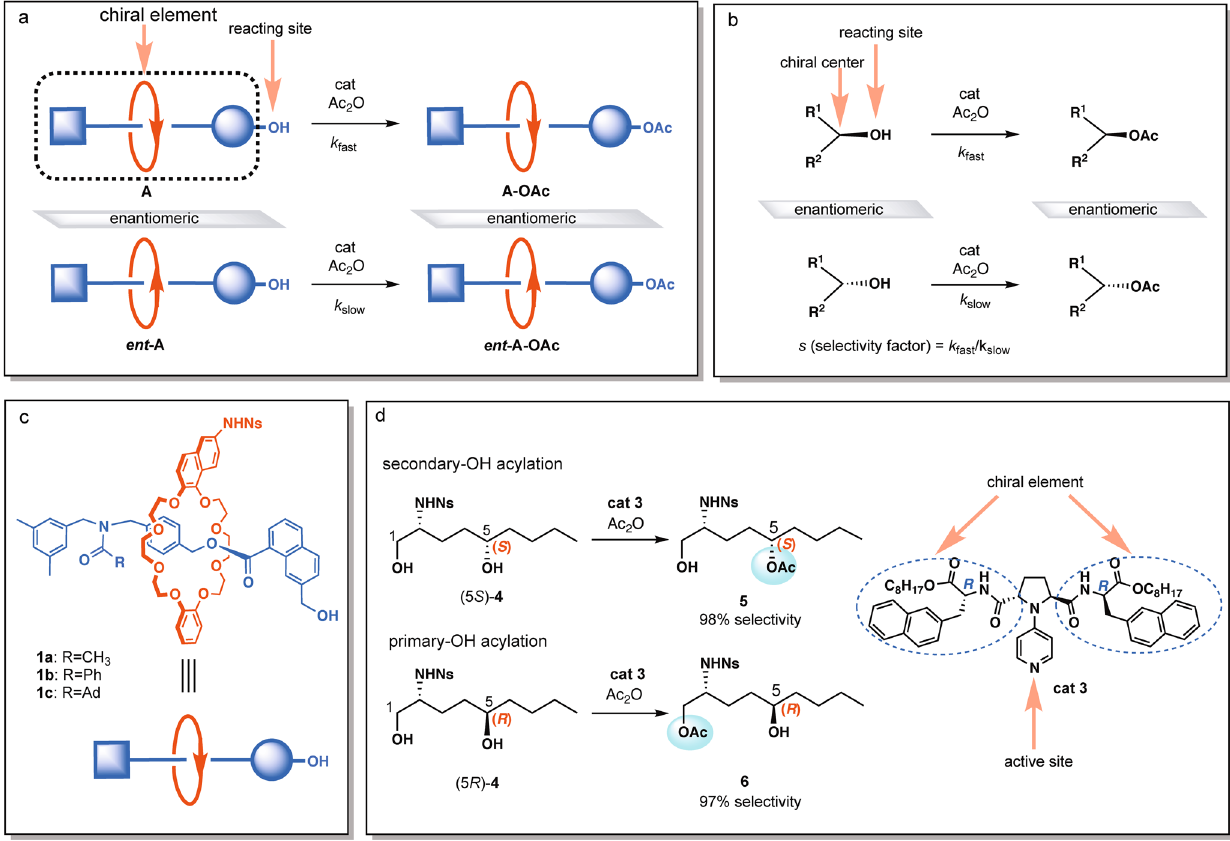
Fig. 2 Strategy for kinetic resolution of racemic rotaxanes. a Uncommon acylative kinetic resolution based on the recognition of remote chirality: Chirality of the substrate is hardly discriminated by the catalyst and/or the reagent upon asymmetric acylation when the chiral element is distal from the reacting center (OH). b Common acylative kinetic resolution based on the recognition of proximal chirality: The substrate chirality is effectively discriminated by the catalyst and/or the reagent upon asymmetric acylation when the chiral center is located close to the reacting center (OH). c Structure of target mechanically planar chiral rotaxane and its schematic presentation. d A hint for remote asymmetric acylation from our previous work: Contrasting chemoselectivity in the acylation of (5 S )- 4 and (5 R )- 4 with catalyst 3